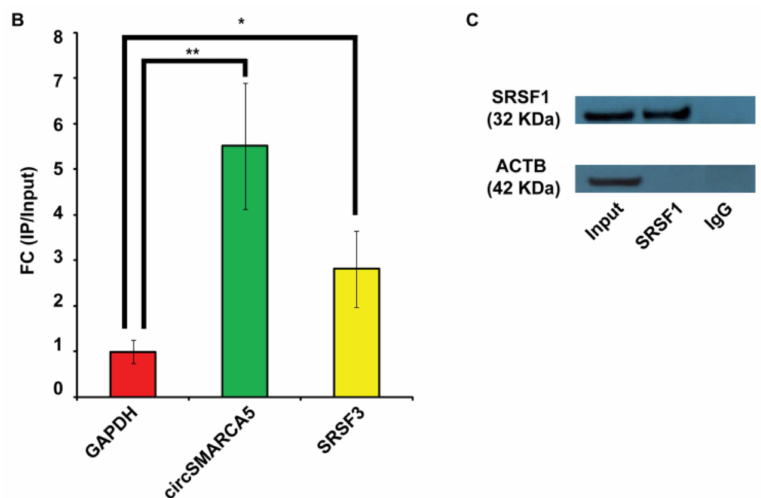
Figure 1. CircSMARCA5 and SRSF1 physically interact within U87-MG cells. ( A ) SRSF1 binding sites predicted by RBPMap database (http://rbpmap.technion.ac.il/) are highlighted with different colors within circSMARCA5 sequence. * indicates sequence conservation among twelve primates, including Homo sapiens (see [19]). ( B ) Fold enrichment (FC) of circSMARCA5, SRSF3 and GAPDH are shown as IPed samples/input. See [22] and Section 4 Materials and Methods for further details (* p -value < 0.05; ** p -value < 0.01, N = 4, two-samples t -test). ( C ) Representative western blot of U87-MG Input, SRSF1 and normal IgG RIPed samples. Antibodies against SRSF1 and Actin Beta (ACTB) were used as described in Section 4 Materials and